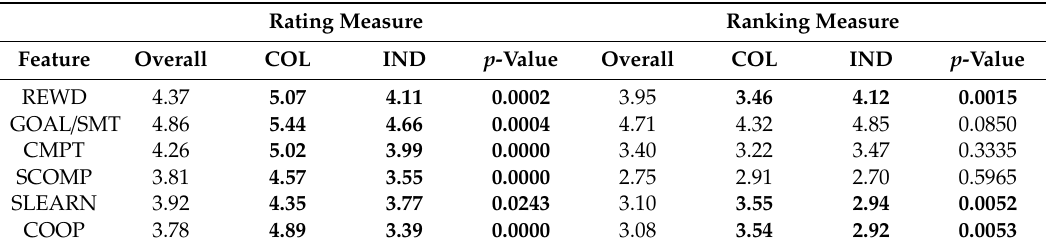
Table 3. Between group comparisons based on a non-parametric Kruskal–Wallis test. COL = Collectivist culture, IND = Individualist culture; the bolded values indicate there is a significant di ff erence ( p < 0.05) between collectivist and individualist scores.